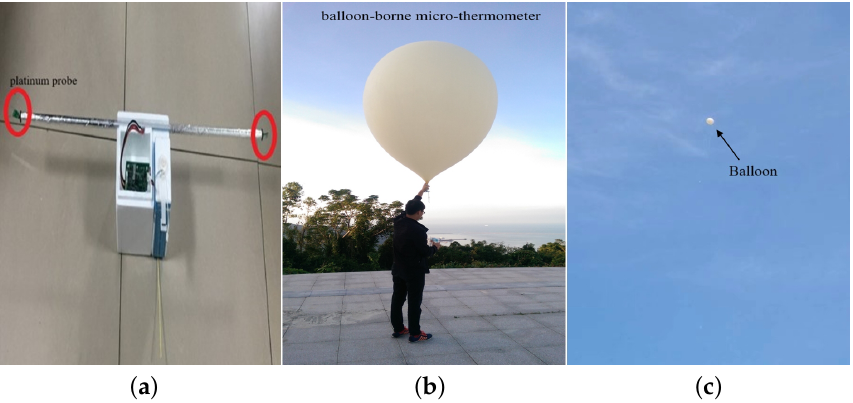
Figure 6. ( a ) Payload of balloon-borne micro-thermometer measurement system. ( b ) Balloon-borne micro-thermometer measurement. ( c ) Balloon. Table 1. The details of measuring